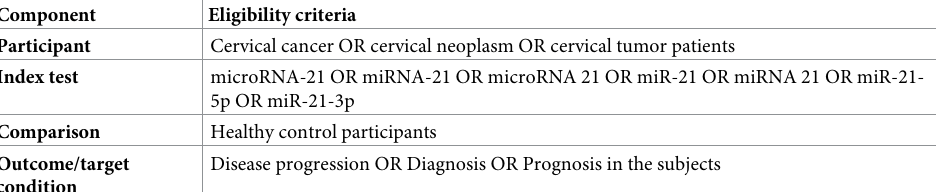
Table 1. Eligibility criteria using PICO (participants, interventions/index test, comparisons, outcomes/target con- dition)